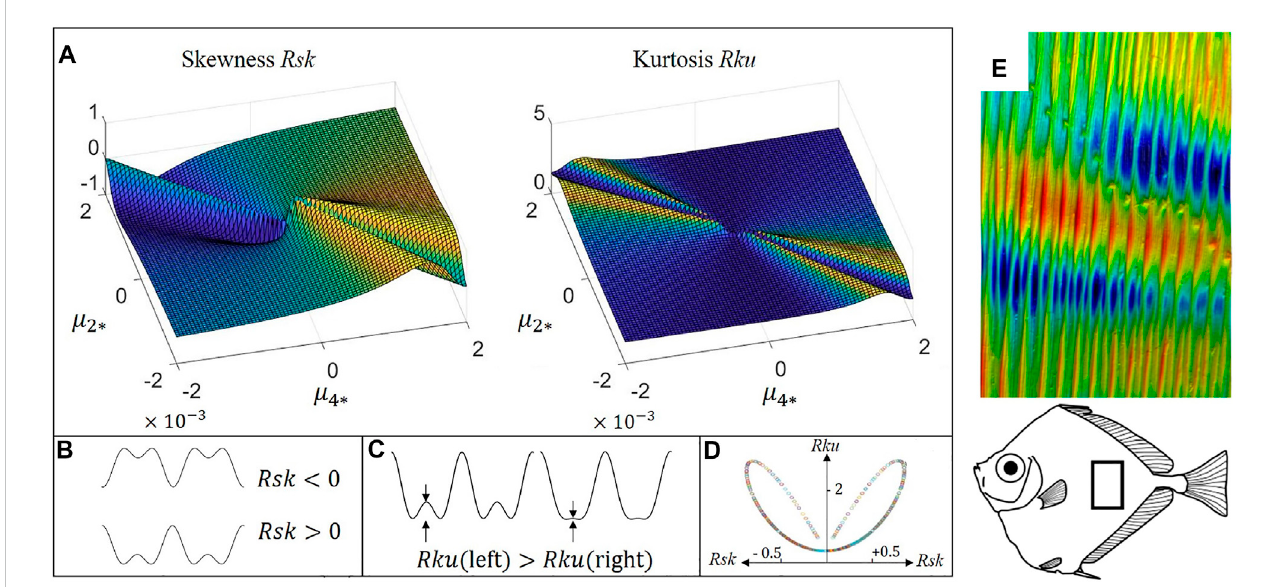
FIGURE 4 Computed surface roughness parameter skewness and kurtosis (Tayebi and Polycarpou, 2004) as a function of dimensionless anchoring parameters, with applications found on the fi sh surfaces: (A) The skewness and kurtosis computed from the pure anchoring model. (B) and (C) are the schematics of the physical meaning of skewness and kurtosis, respectively. (D) Is the skewness-kurtosis plot obtained from (A) . (E) The cylindrical surface wrinkling of spotted tinsel fi sh ( Xenolepidichthys dalgleishi ): 9.22 mm × 13.6 mm, amplitude z :388 μ m. (A – D) are reprinted with permission from (Wang et al., 2020a). Copyright (2020) by the American Physical Society. (E) Is reprinted with permission from (Wainwright et al., 2017). Copyright (2017) by the John Wiley &